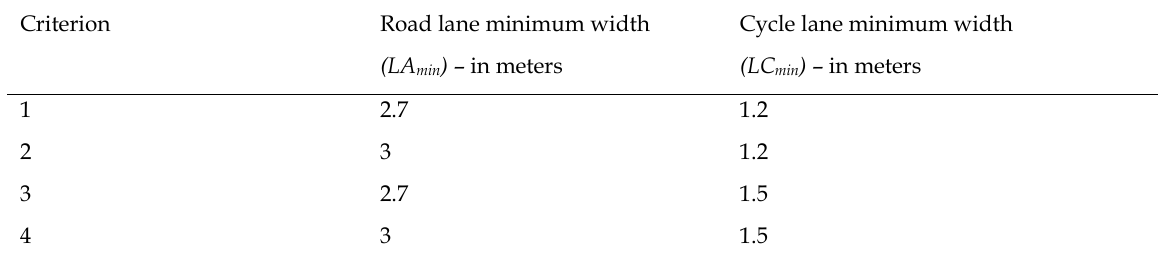
Table 1. Combinations of desirable and acceptable lane width criteria for cycle lane inclusion